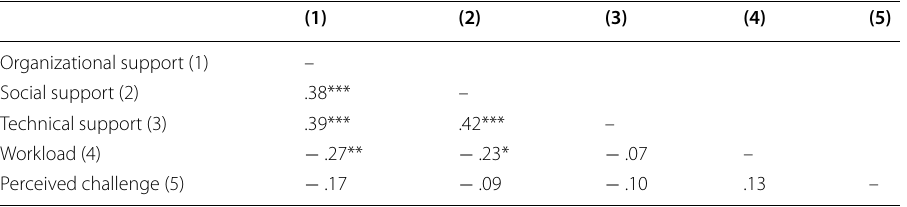
Table 3 Zero-order correlations (Spearman’s